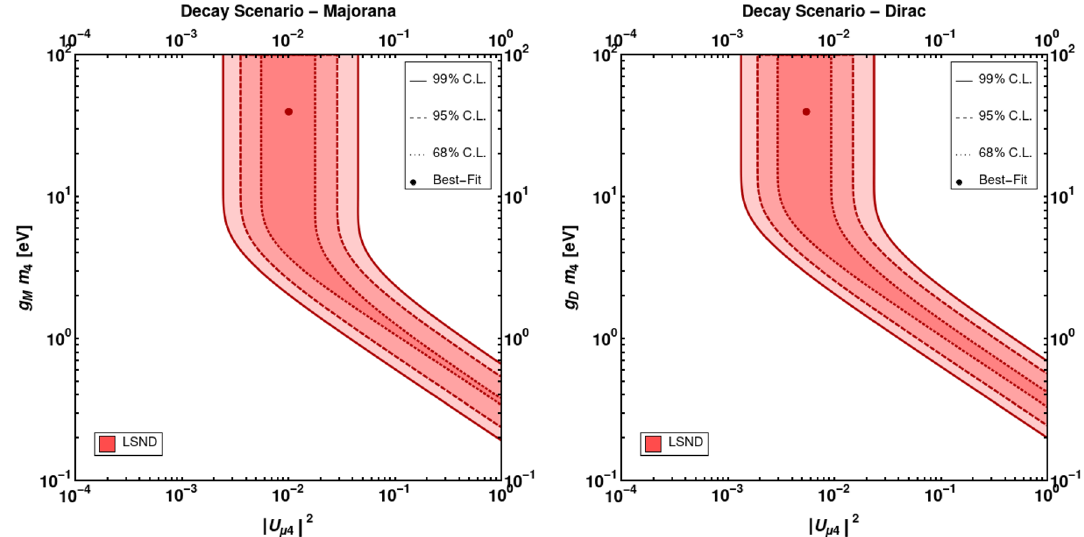
Figure 2 . Allowed regions of the ( j U (cid:22) 4 j 2 ; gm 4 ) parameter space when the decaying-sterile-neutrino hypothesis is matched against the LSND data assuming Majorana (left) or Dirac neutrinos (right). The dots indicate the best-(cid:12)t-point and the lines represent the 99% (solid), 95% (dashed) and 68% (dotted) con(cid:12)dence level (C.L.)